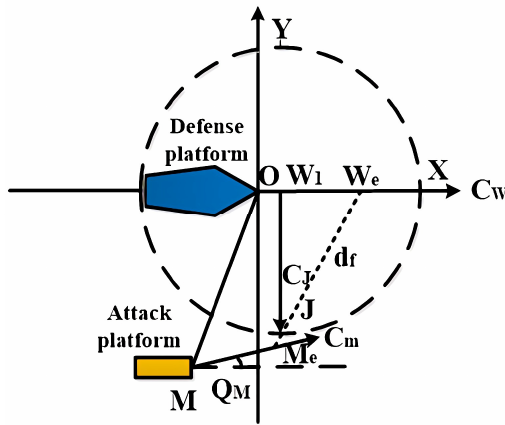
Figure 3. The jammer deployment scheme.